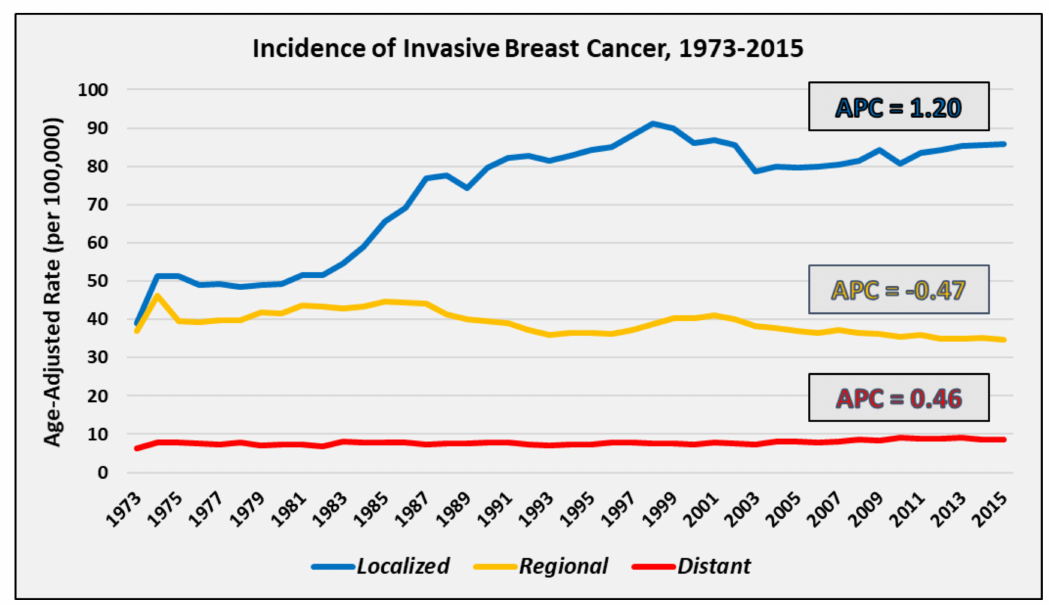
Figure 1. Age-adjusted incidence of localized, regional, and distant breast cancer in women, from 1973 to 2015 (SEER 9). APC: annual percent